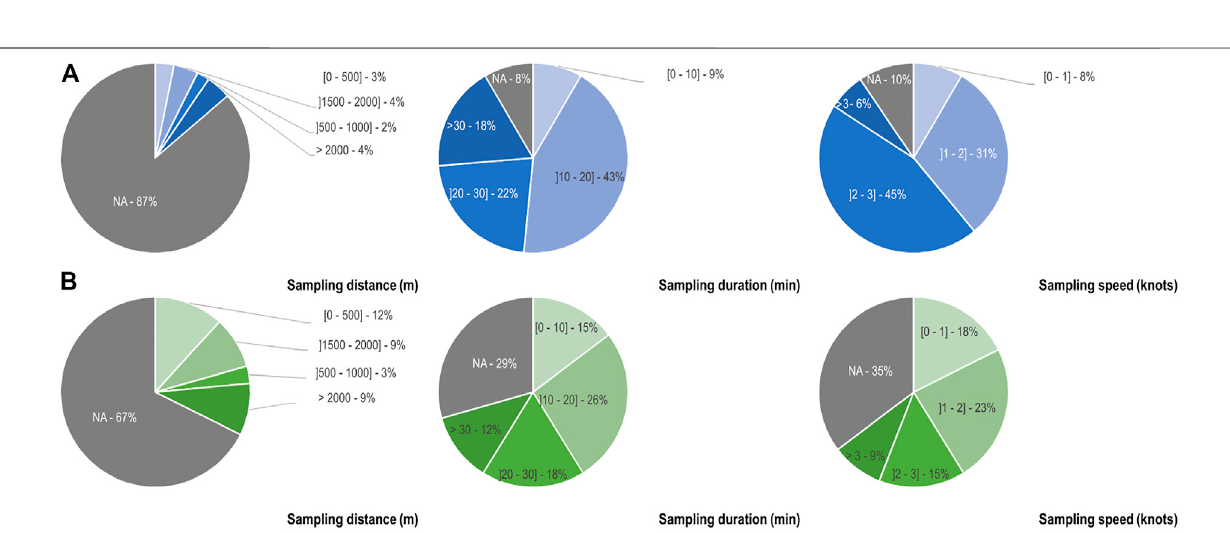
Frontiers in Environmental Science |